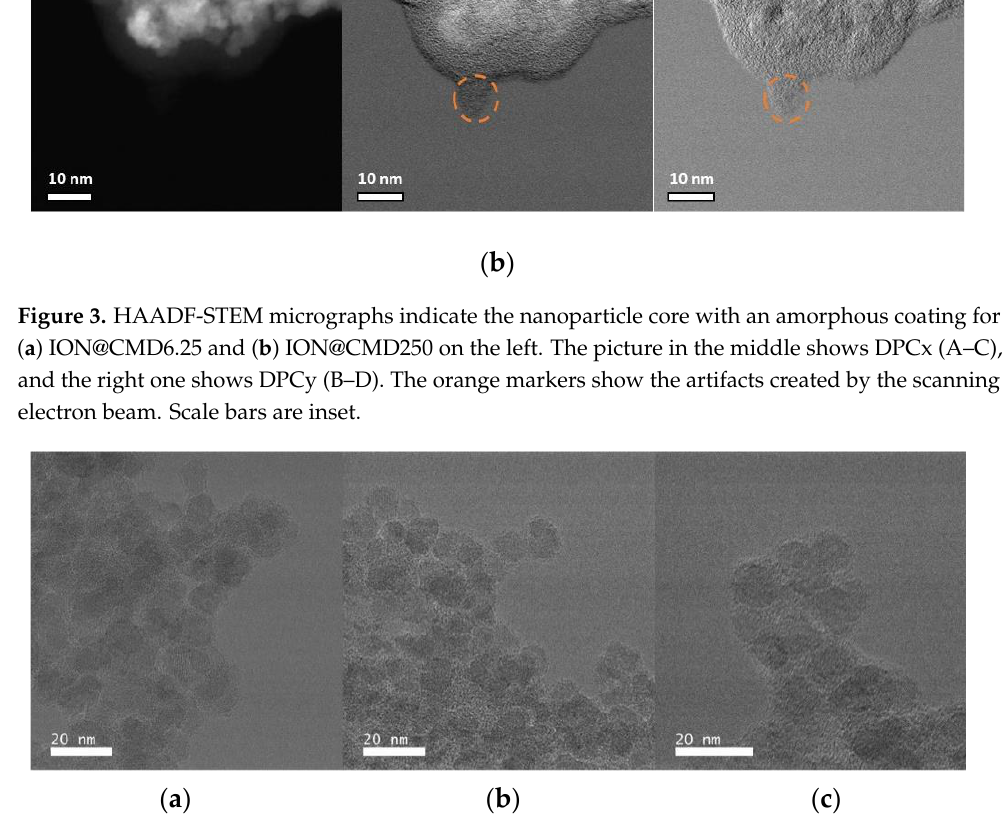
Figure 4. Low-dose TEM micrographs of ( a ) ION@CMD250, ( b ) ION@CMD12.5, and ( c ) IONs@CMD6.25. These micrographs were acquired using the dose fractionation method, where 40 micrographs were taken with bursts of 0.1 s of exposure and subsequently aligned and summed.